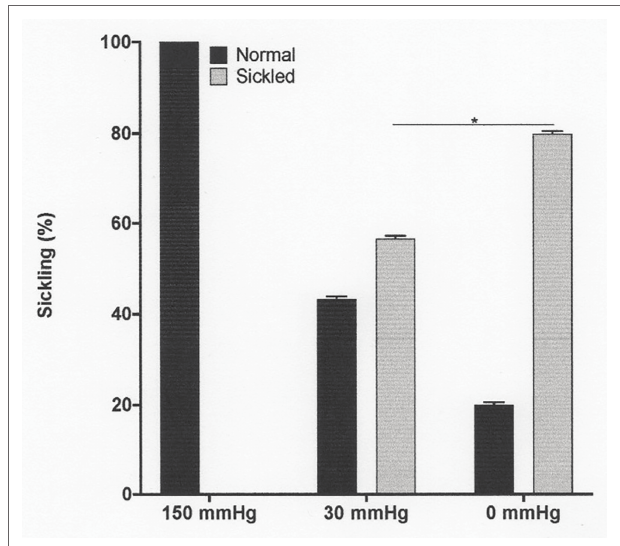
FIGURE 1 | The effect of oxygen tension on sickling of red cells from patients with sickle cell anaemia (SCA). Red cells (1% haematocrit, Hct) were incubated in Eschweiler tonometers at 37 ° C and pH 7.4 for 15 min and equilibrated with warm humidified gas at three different oxygen tension (150, 30, and 0 mmHg oxygen – air replaced with nitrogen). Red cell aliquots were then removed and fixed using 0.3% glutaraldehyde, whilst maintaining the same oxygen tension present during their incubation. Histograms represent means ± SEM, n = 3. * p <